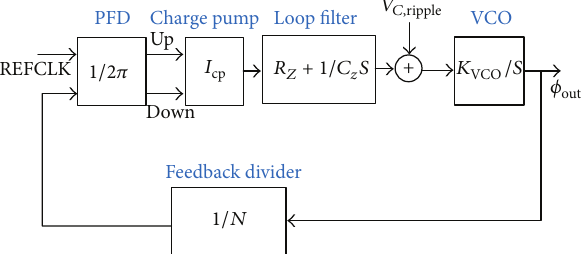
Figure 5: Closed-loop AC model of a charge pump-based PLL.